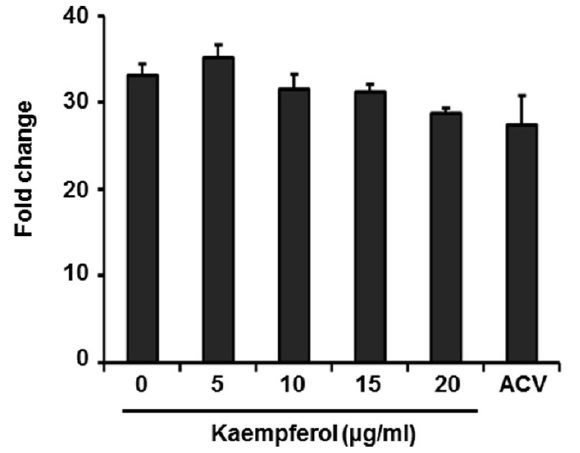
Figure 3. Effect of kaempferol on VZV IE promoter activity. HEK293T cells were transfected with VZV IE promoter-driven firefly luciferase plus control Renilla luciferase plasmids. Cells were treated with kaempferol, acyclovir (ACV), or DMSO at 6 h after transfection, and promoter activity was analyzed using a dual luciferase assay at 18 h after treatment. Relative luciferase activity was calculated as VZV IE promoter-driven firefly luciferase activity relative to that in cells transfected with the control vector (defined as 1). Data represent the average of three independent